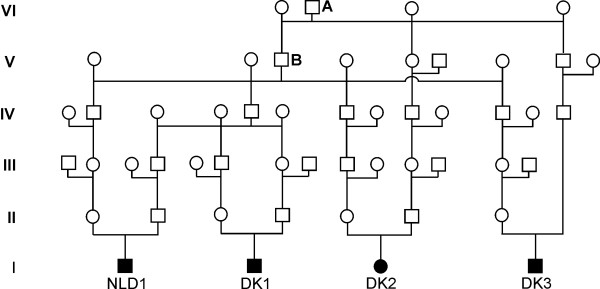
Genealogic diagram showing the genetic relationship between four cases of the brachyspina syndrome. Three Danish cases of the bovine brachyspina syndrome (DK1–3) and a Dutch case (NLD1) are genetically related within 6 generations. Each affected calf is the result of breeding between genetically related animals and all parents are related to a common ancestor (A) in generation VI, often through his son (B). □ = phenotypically normal male; ○ = phenotypically normal female; ■ = affected male; ● = affected female.